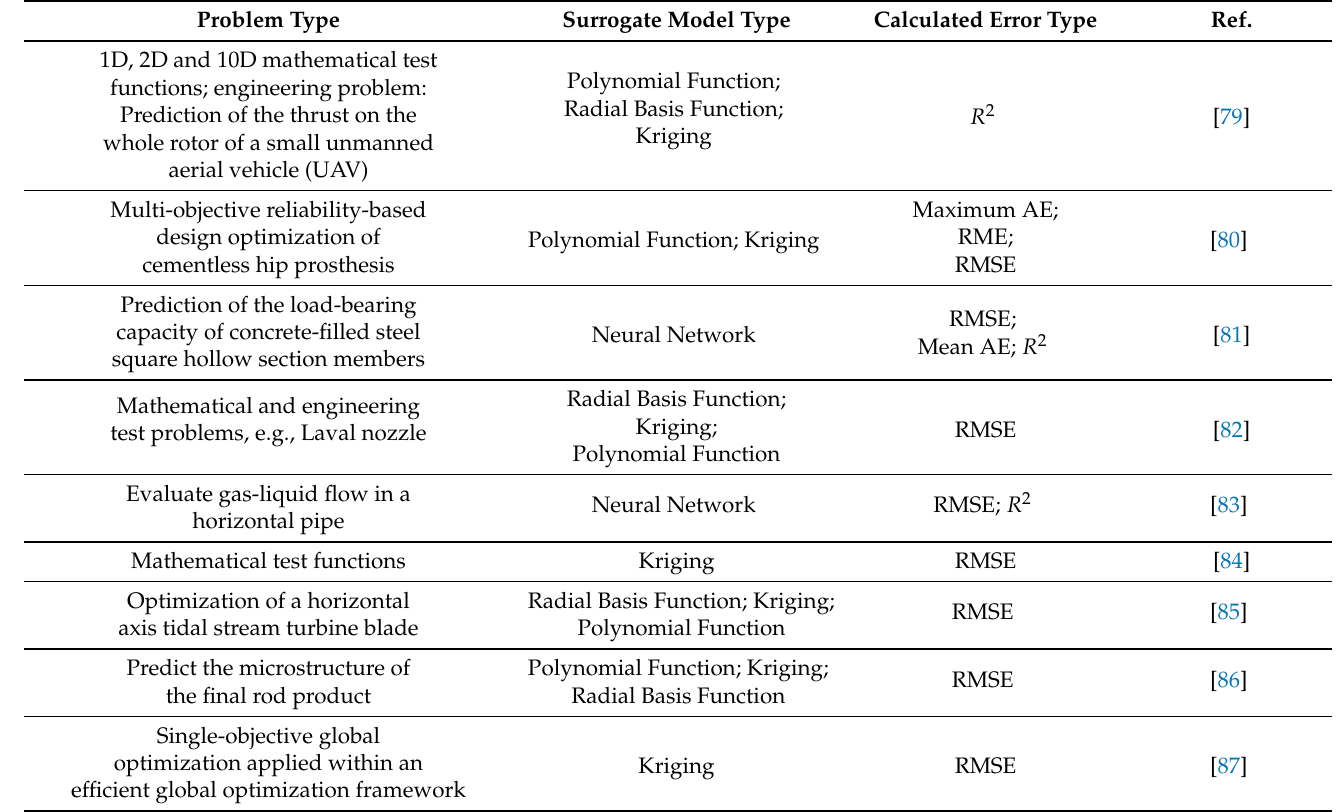
Table 5. The applied calculated error types and surrogate model types for different application problems (Absolute Error (AE); Relative Mean Error (RME); Root Mean Square Error